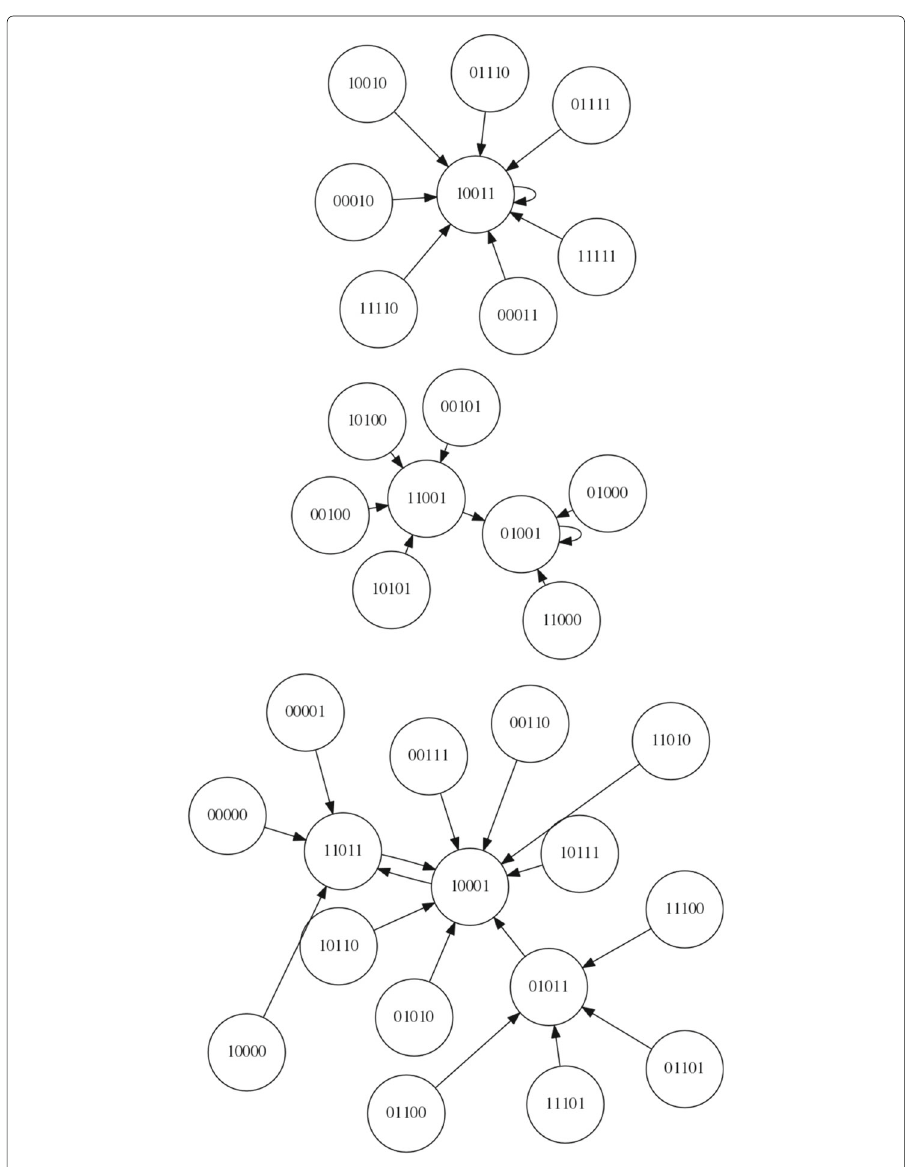
Fig. 10 NK Boolean network, instantiation 4 ( N = 5, K =